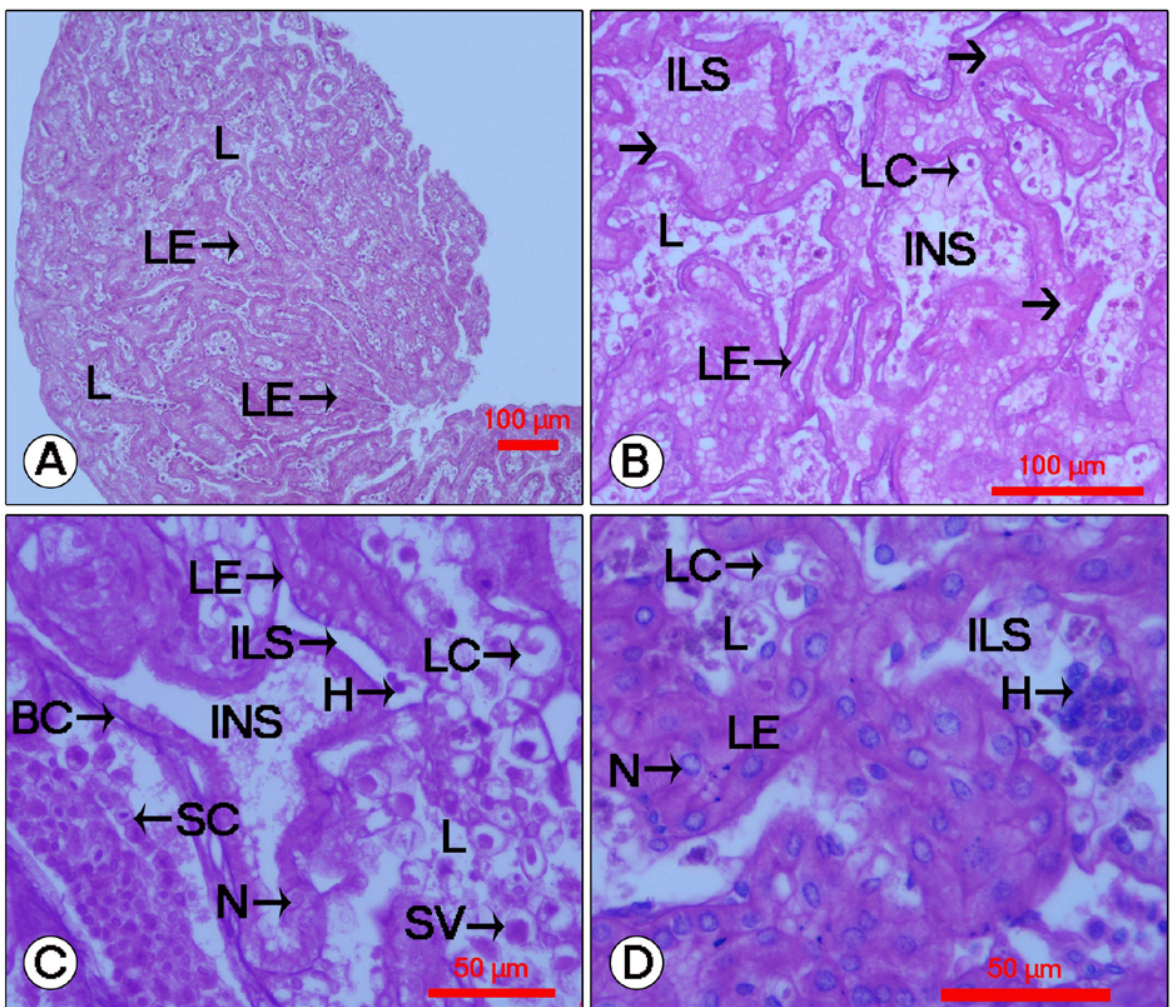
Figure 3. Light micrograph of histology of Y-organ of crabs treated with 20E during C3 stage in Travancoriana schirnerae. ( A ) Closely packed branched lobules with reduced intra- and inter-lobular spaces. ( B ) Compactly packed, small irregular shaped cells without nuclei in the inter-lobular spaces. ( C ) Y-organ demonstrating patches of proliferated smaller cells, larger cells carrying secretory vesicles and fine capillaries. ( D ) Lobules surrounded by multilayered epithelium and inter-lobular hemal spaces with hemocytes. BC: Blood capillary; H: Hemocyte; ILS: Inter-lobular space; INS: Intra-lobular space; L: Lobule; LC: Larger cell; LE: Lobular epithelium; N: Nucleus; SC: Smaller cell; SV: Secretory vesicle, Arrow indicates small irregular shaped cells without